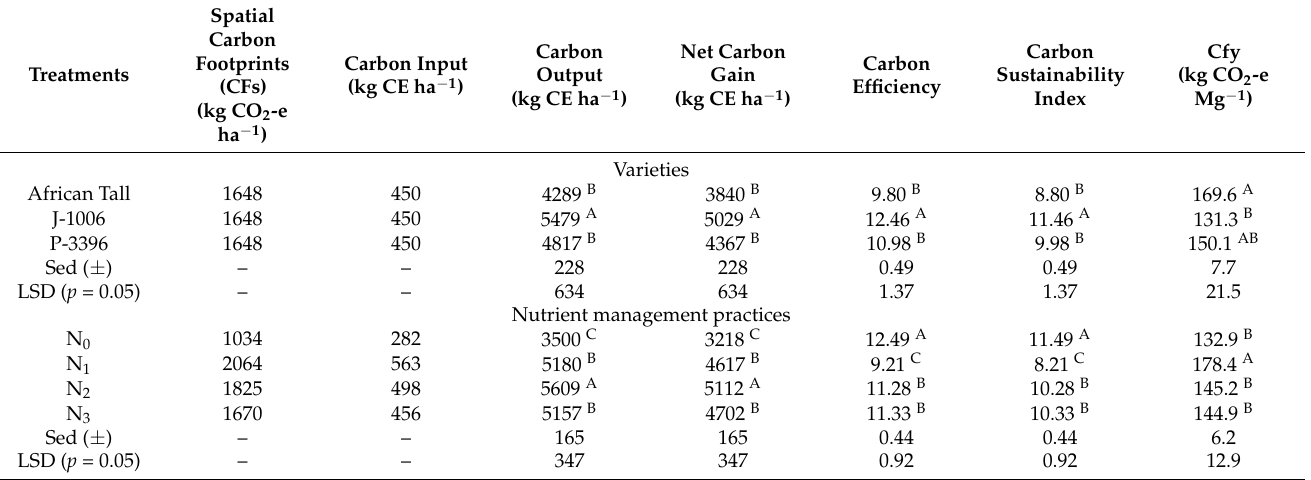
Table 5. Spatial carbon footprints, carbon inputs, outputs, and carbon indices of fodder maize varieties sown under different nutrient management practices (mean of two